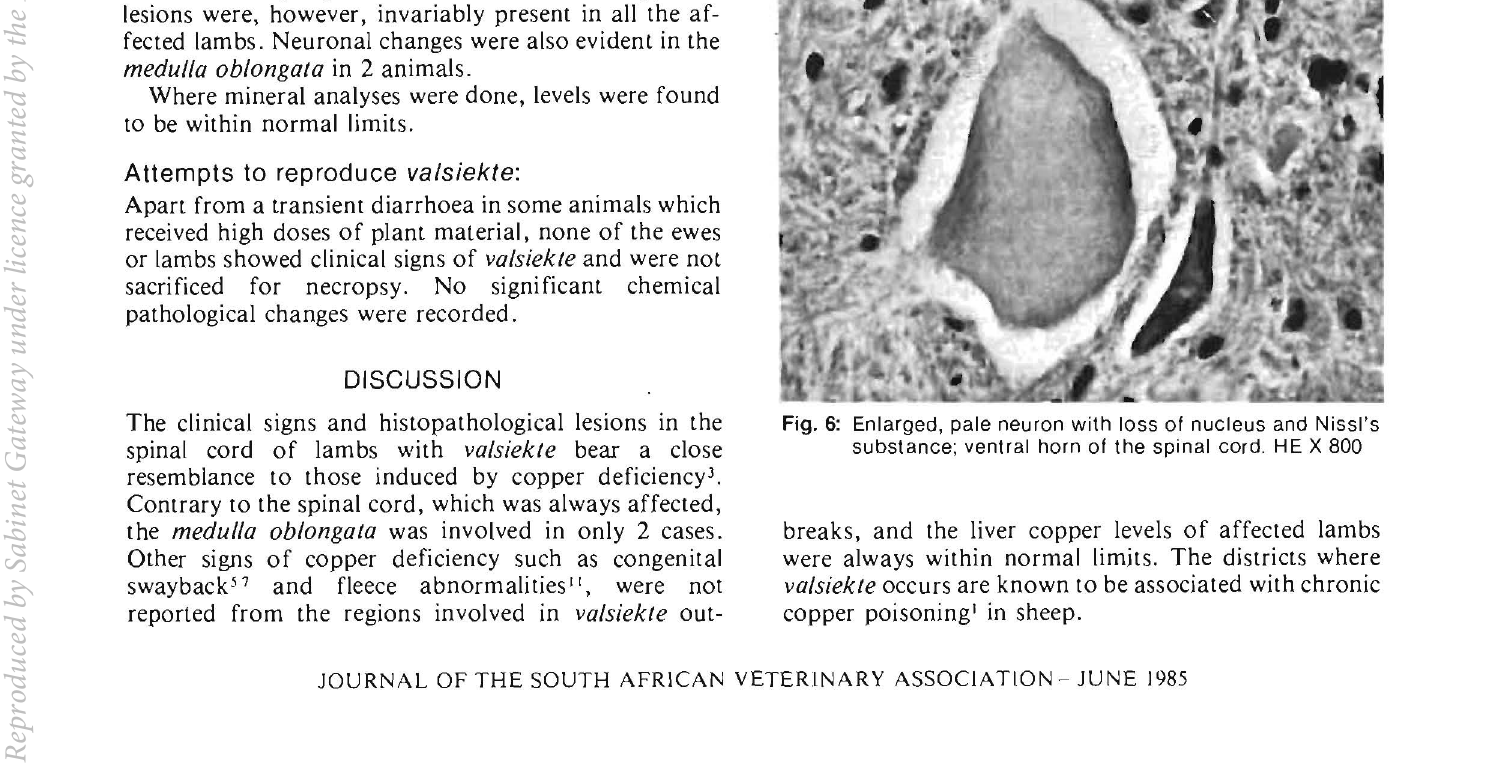
... Fig. 5: Two large neuronal cytoplasmic vacuoles; ventral horn of the spinal cord. HE X 800